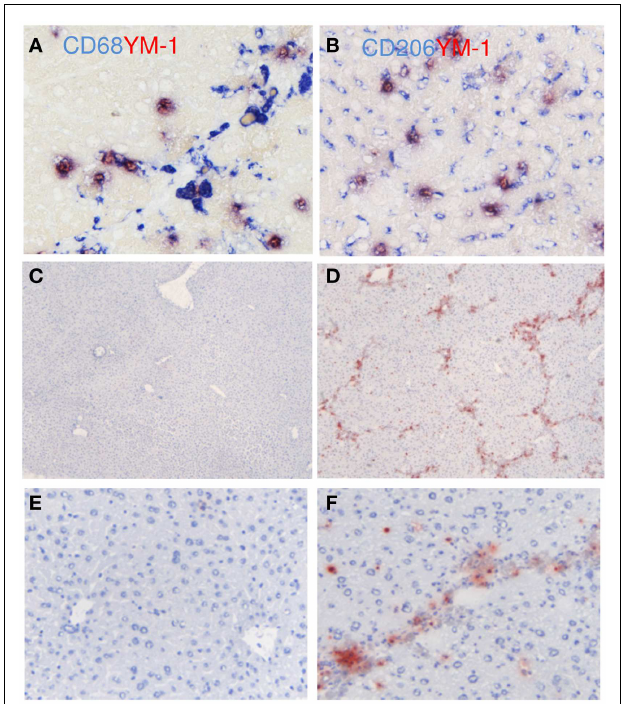
FIGURE 7 | Localization ofYM-1 (M2) in mouse livers . (A) Co-localization ofYM-1 (red staining) and CD68 (blue staining). (B) Co-localization ofYM-1 (red staining) and CD206 (blue staining). (C–F) Immunohistochemical localization ofYM-1 in livers of normal mice (C,E) and in advanced fibrosis (D,F) . Magnifications: 40 × (C,D) , 200 × (E,F) , and 400 × (A,B) . N = 4 normal mouse livers, N = 6 fibrotic mouse livers.